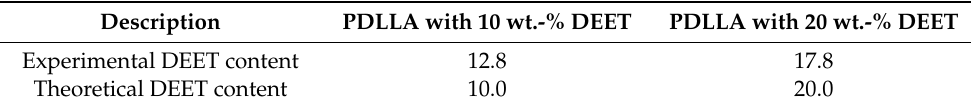
Table 3. Estimated DEET content of PDLLA monofilaments with varying DEET content.